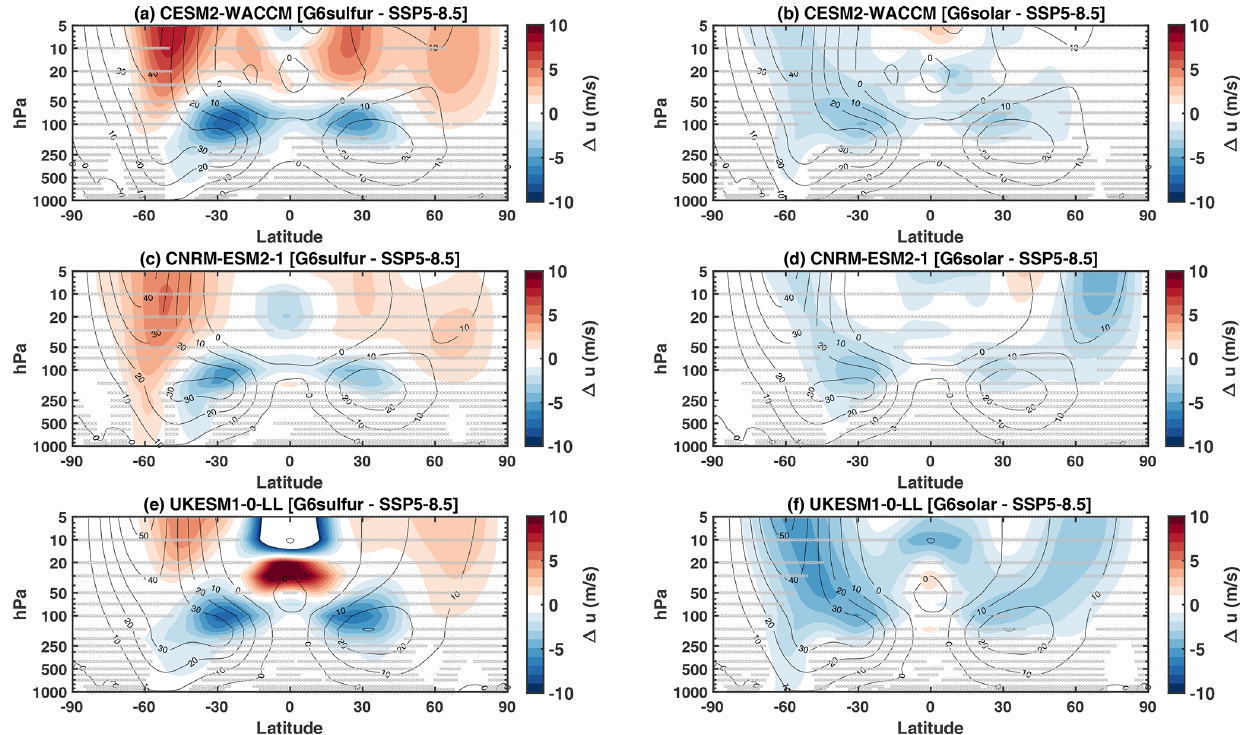
Figure 4. Zonal mean zonal wind changes (ms − 1 ) (2080–2089) between G6sulfur and SSP5-8.5 (a, c, e) and G6solar and SSP5-8.5 (b, d, f) for the three GeoMIP models with interactive chemistry that participated in the G6 experiment. Contour lines show the baseline SSP5-8.5 winds. Gray horizontal lines indicate changes that are not statistically significant over the period considered when using a double-sided t test at 95% confidence